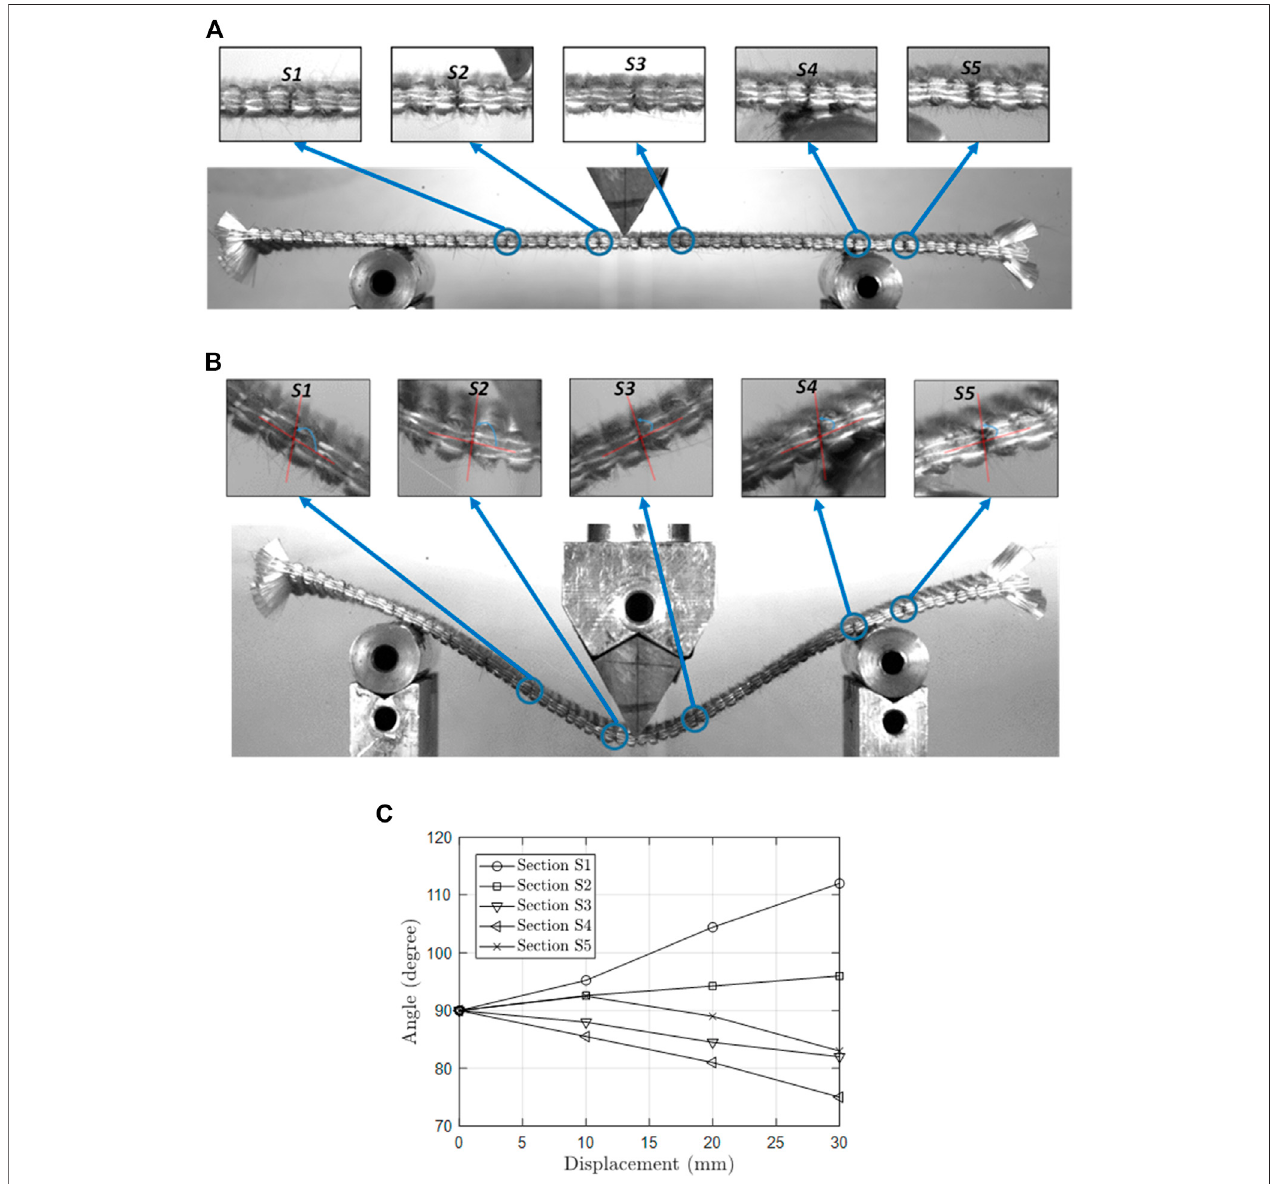
FIGURE8| Cross sections ofthereinforcement (A) initial state, (B) after adisplacementof30 mm. (C) Anglebetweenthedifferentcross sections and themid-line of the reinforcement during loading.